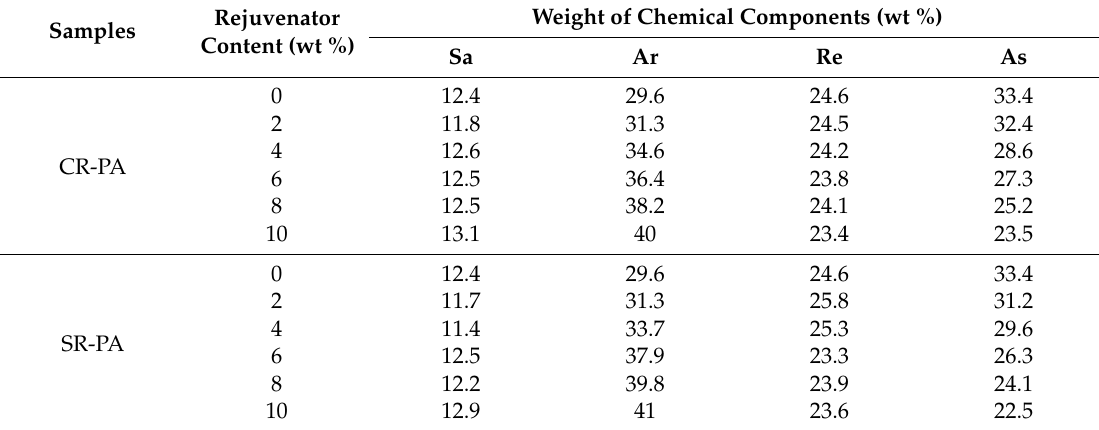
Table 5. Chemical components of regenerated PA containing CR and SR.